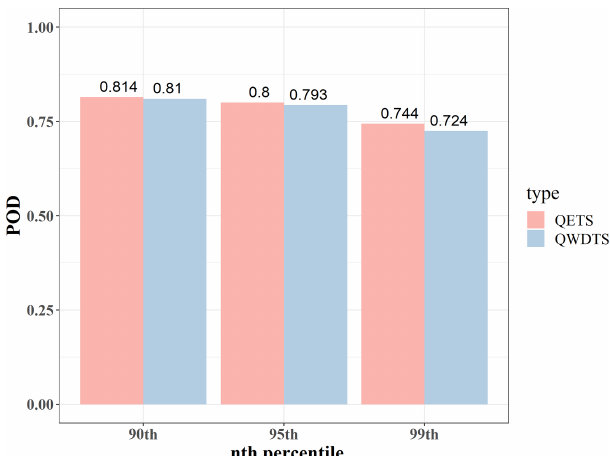
Figure 15. Histogram of the POD in the 261 river basins. Figure 16. Influence of the selected threshold and extreme precip- itation standard on the